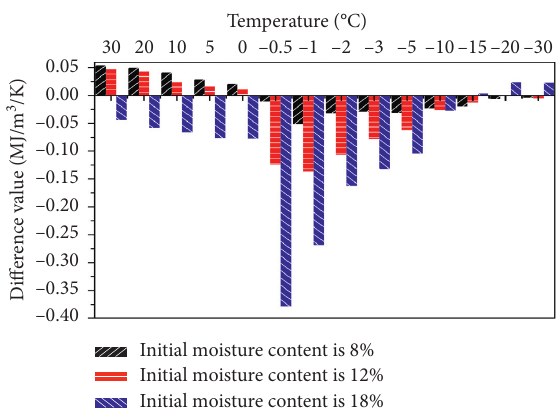
Figure 9: Difference values between the calculated values and the tested